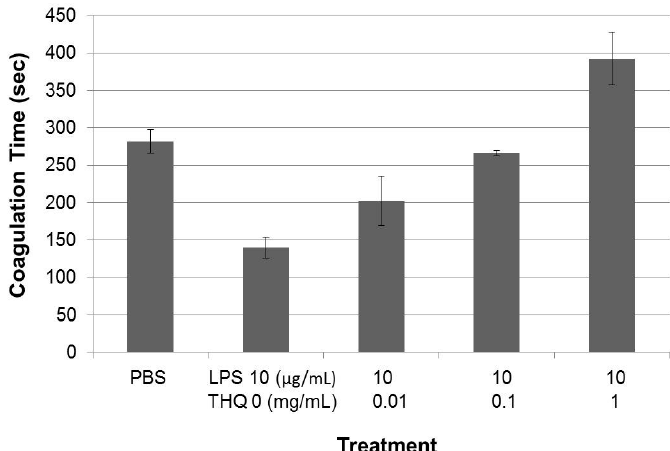
Figure 4. THQ reverses coagulation mediated by lipopolysaccharide (LPS). Increasing concentrations of THQ were pre-incubated with whole blood at 37 °C for 1 h. After the pre-incubation, LPS was added to the blood and incubated for an additional 2 h at 37 °C. The coagulation time of the blood was analyzed with TEG assay. LPS-treatment significantly ( p < 0.001) decreased the clotting time compared to PBS control, by ANOVA with post hoc (Tukey) analysis. Pre-incubation with THQ caused significant ( p < 0.001) reversal of coagulation mediated by LPS at 0.1 and 1 mg/mL by ANOVA with post hoc (Tukey) analysis. Note that the coagulation time is back to that of PBS control at 0.1 mg/mL of THQ concentration. The experiments were performed twice in triplicate. Error bars show the standard deviations of the mean values.